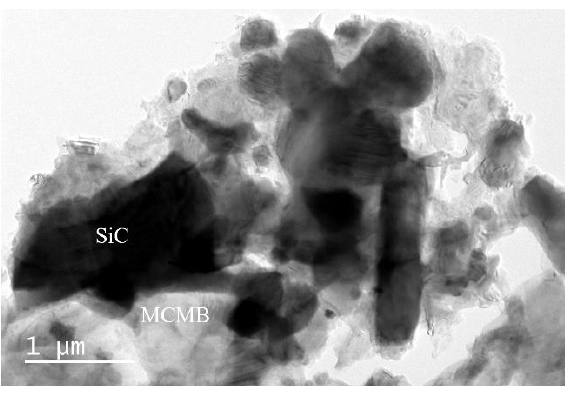
Figure 6. ( a ) TEM and ( b ) high resolution TEM (HRTEM) images of sample M-10. Materials 2019 , 12 , x FOR PEER REVIEW